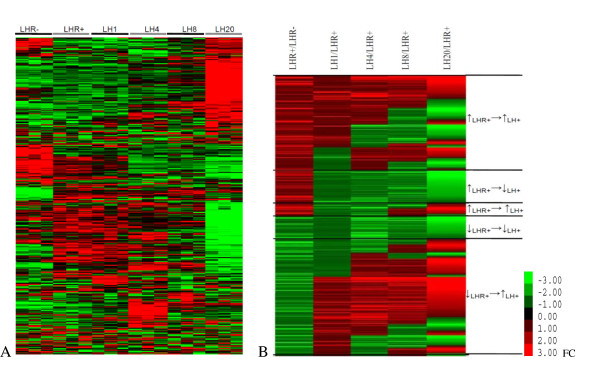
A. A heatmap showing normalized gene-expression profiles for SKOV-3 cells under six conditions. B. A heatmap showing gene-expression patterns under different regulation (for each group, the mean expression value of the three replicates is shown, and the five transitions are LHR+/LHR-, LH1/LHR+, LH4/LHR+, LH8/LHR+ and LH20/LHR+), where LHR- denotes the control or mock-transfected SKOV-3 cells, and all others are the LHR+ cells with no LH added or after incubation with LH for 1, 4, 8, and 20 h, respectively.